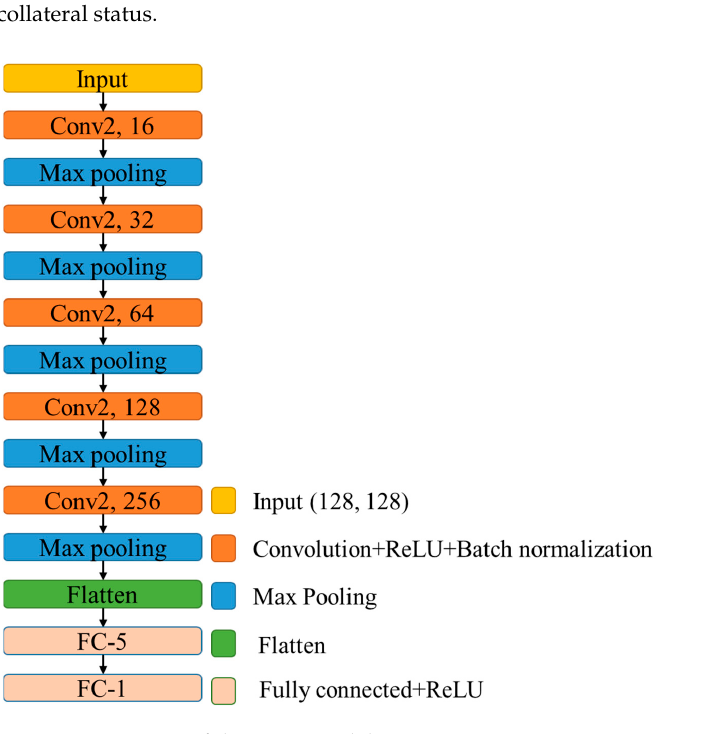
Figure 3. Structure of the CNN model.